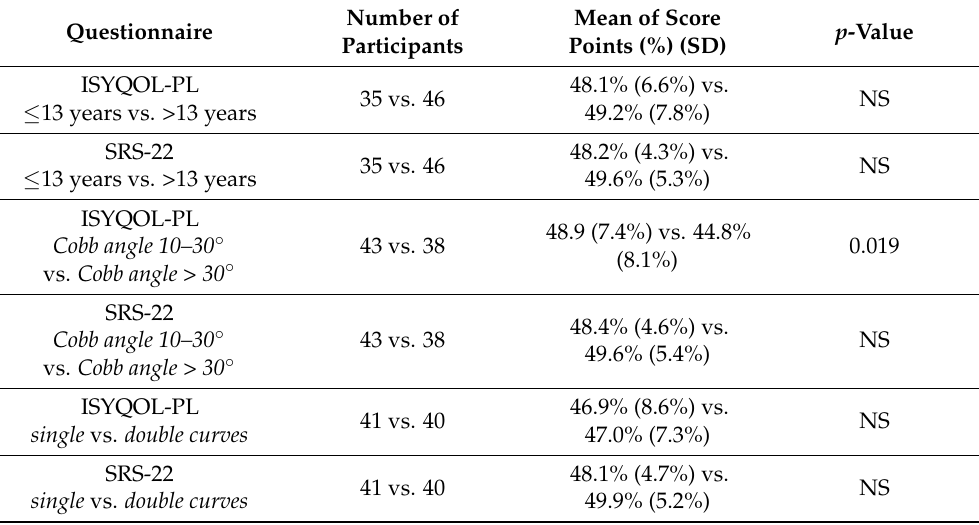
Table 2. The known-groups validity analysis of the ISYQOL-PL and the SRS-22 questionnaires.